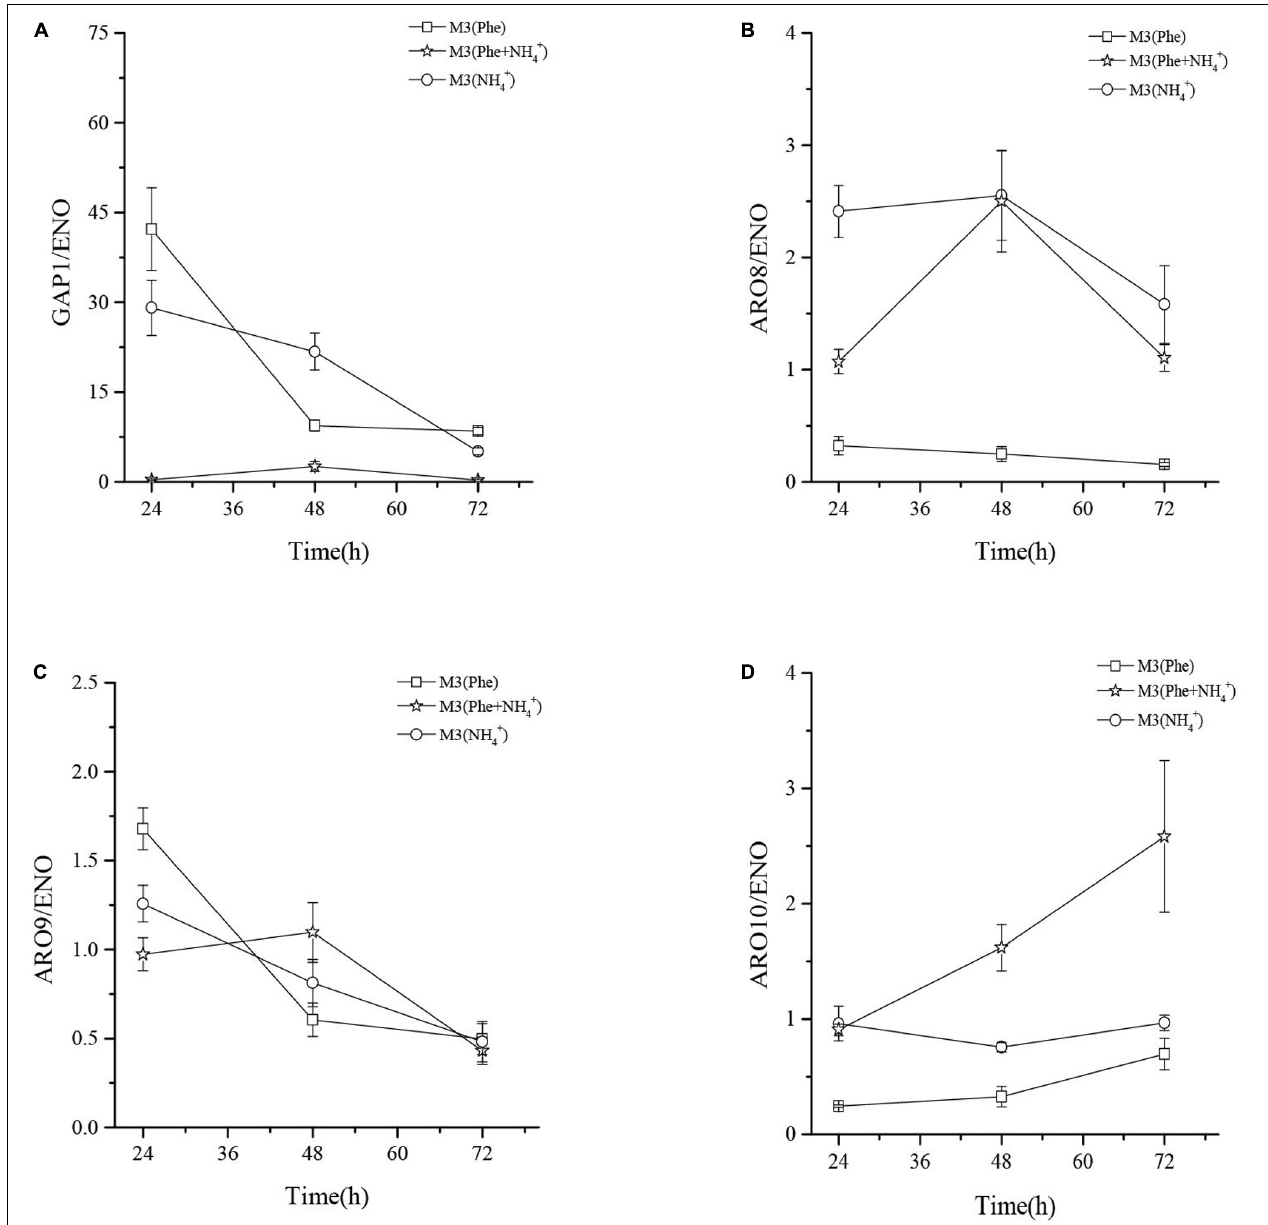
FIGURE 7 | The mRNA relative expression levels of GAP1 (A) , ARO8 (B) , ARO9 (C) , and ARO10 (D) of Z. rouxii M2013310 in three different culture